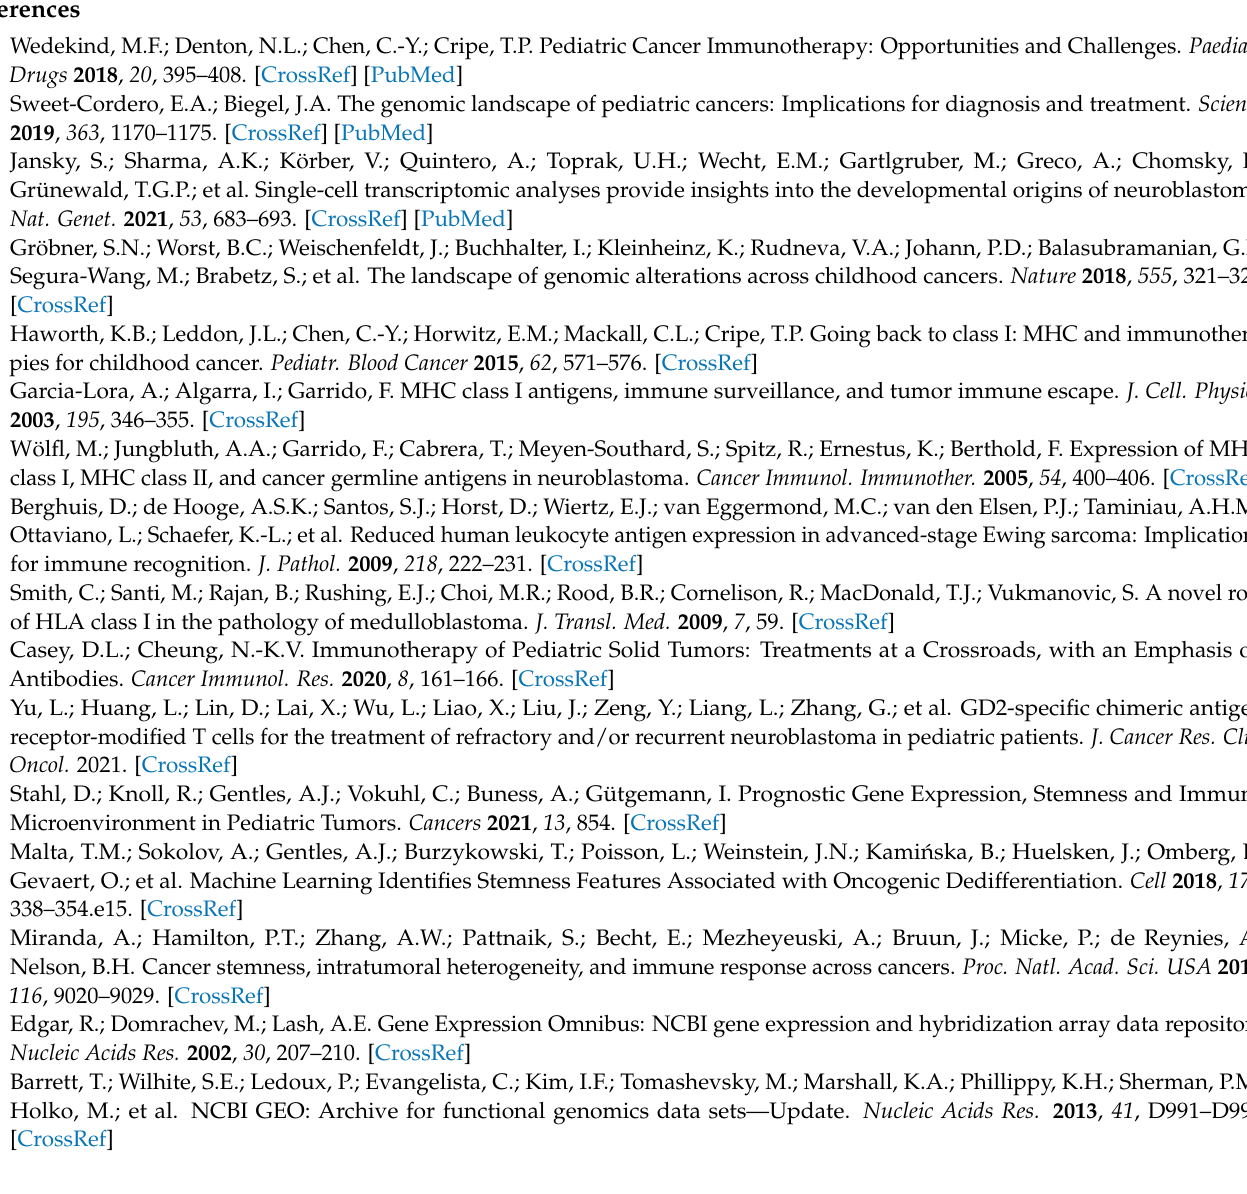
per cancer type are shown. Table S2: Correlation values (Spearman’s rank correlation coefficient) between mRNAsi and mean MHC class I expression within all datasets included in this